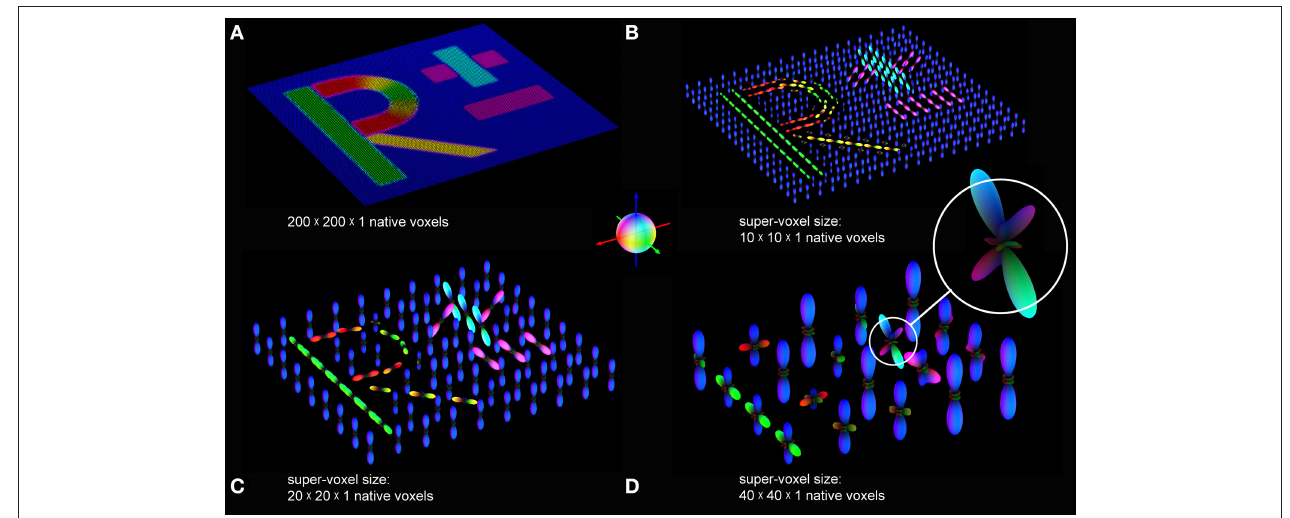
FIGURE 4 | pliODFs based on different super-voxel sizes. (A) The FOM of the simulated dataset (cf. Figure 2 ) was divided into super-voxels composed of (B) 10 × 10 × 1, (C) 20 × 20 × 1, and (D) 40 × 40 × 1 native voxels. pliODFs were generated by means of series expansions to the 6th band for the different super-voxels. The color sphere defines the relation between orientation and